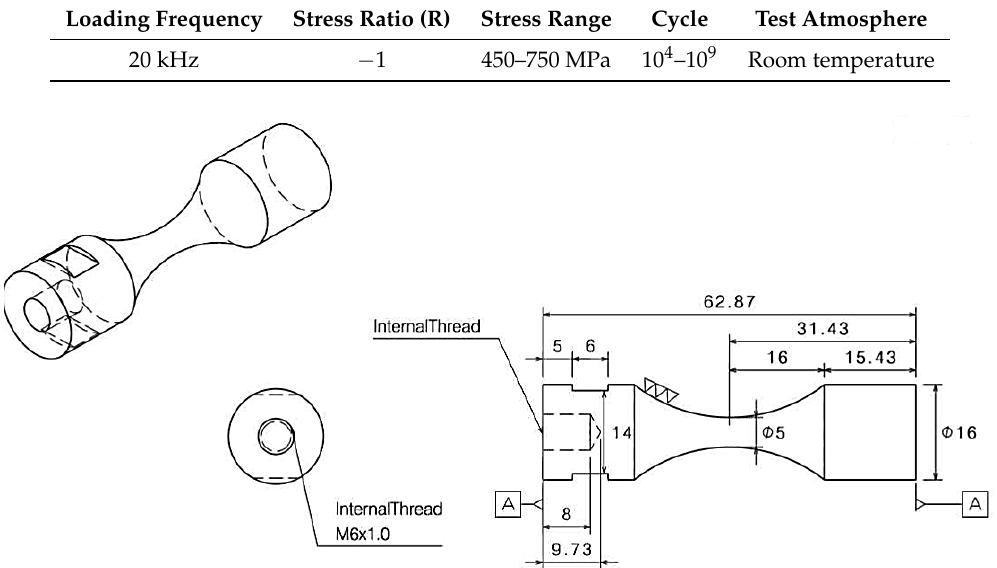
Figure 7. Specification of ASTM E8 ultrasonic fatigue test specimen.